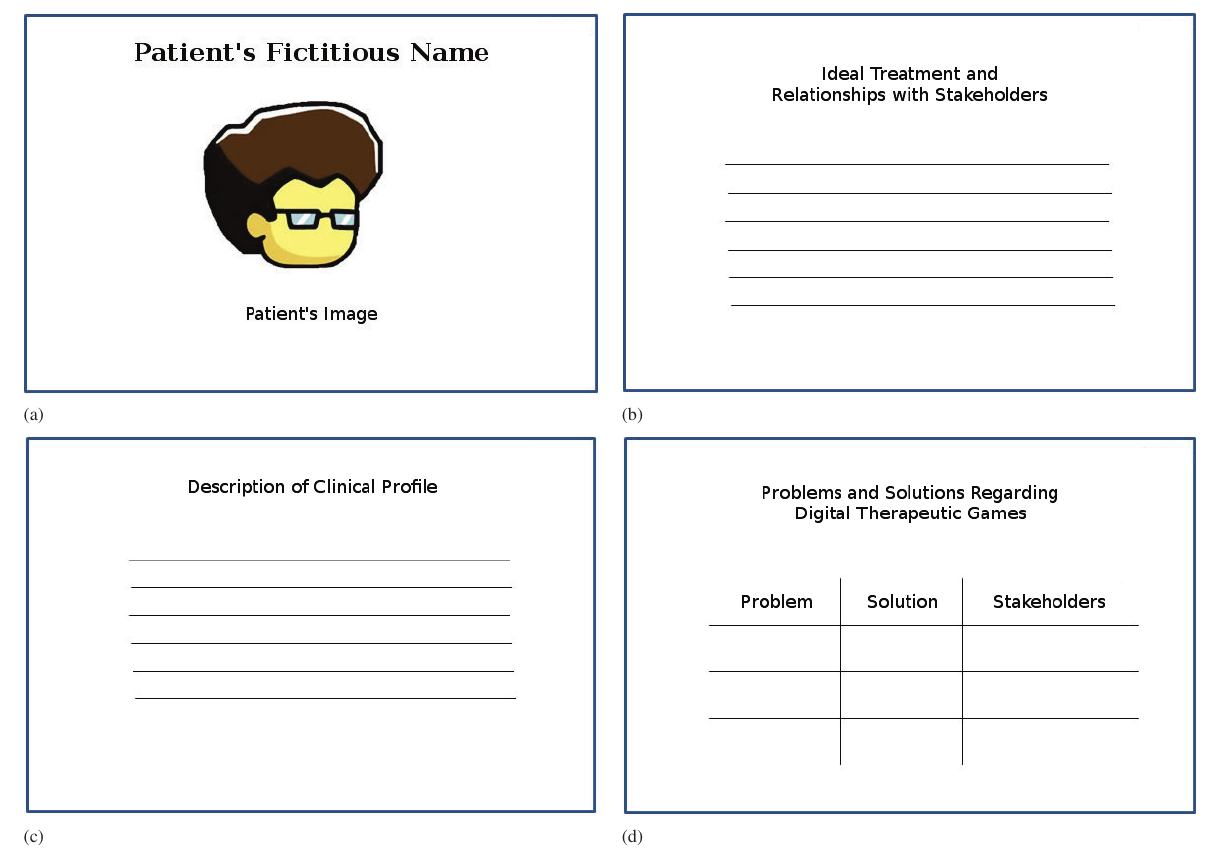
Fig. 3. Design Artifact for characterizing the end-users of the therapeutic application.